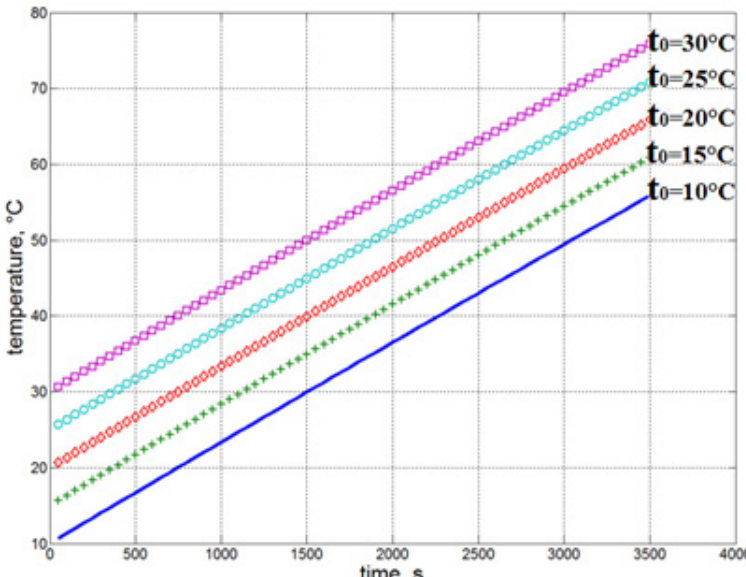
Figure 2. Variation of the reaction temperature with surrounding temperature (10 °C < t 0 < 30 °C) during the neutralization step using MgO.